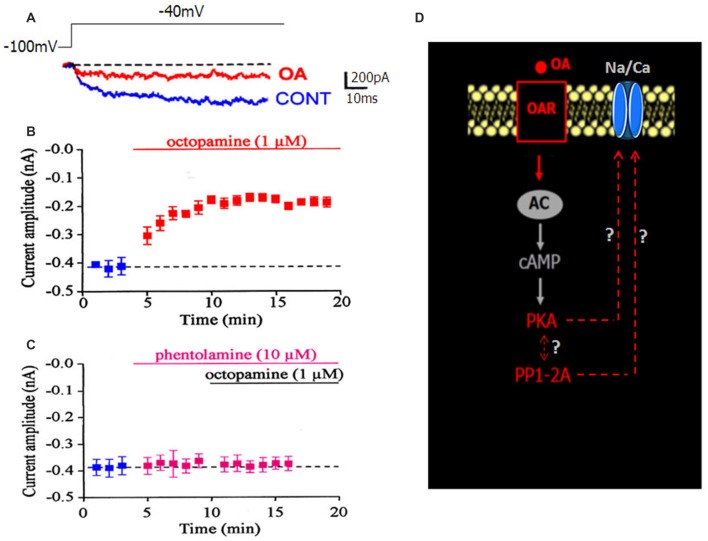
Effect of OA on the LVA maintained Na/Ca inward current. (A) Superimposed current traces generated by depolarizing pulse to −40 mV from a holding potential of −100 mV and recorded in control condition (blue current trace) and in the presence of 1 μM OA (red current trace). (B) Time course of changed maximum current amplitude induced by bath application of 1 μM OA. (C) Pretreatment of DUM neuron cell body by the OA receptor (OAR) antagonist, phentolamine (10 μM), completely blocked the OA-induced decrease current amplitude. In both cases, data are means ± SEM. (D) Hypothetic scheme illustrating the involvement of OAR activated by OA (red characters) in the modulation of the LVA maintained Na/Ca inward current amplitude.